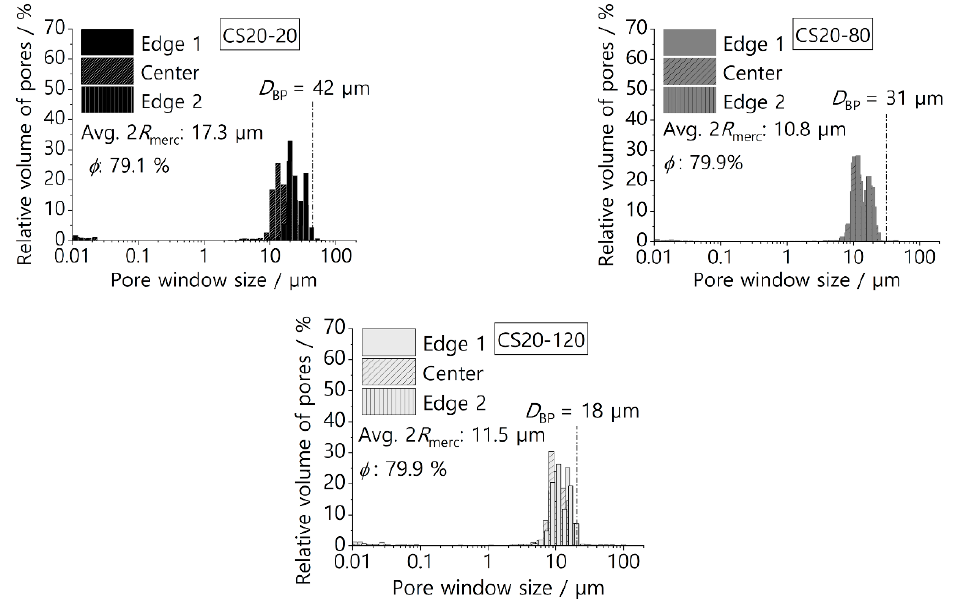
Figure 6. Hg intrusion porosimetry diagram for samples with a solid loading of 20 wt% for different freezing temperatures. Dashed lines indicate the biggest pore window size calculated based on bubble point pressure D BP